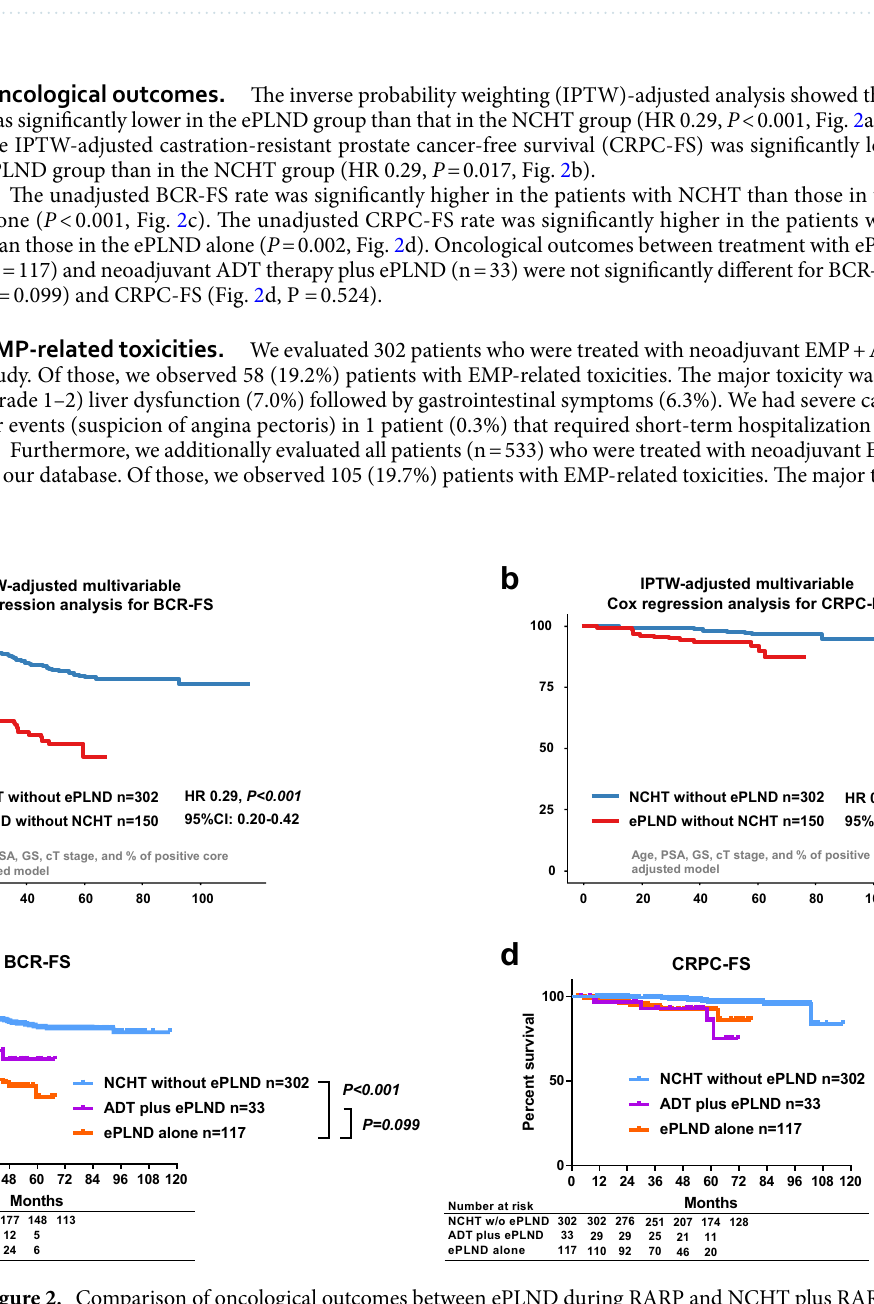
Table 3. Multivariable logistic regression analysis for postoperative complication.